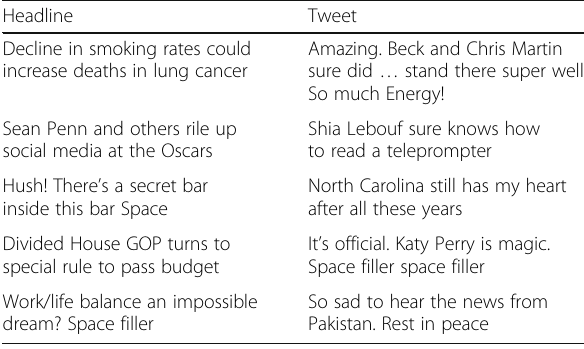
Table 2 Sample headlines and